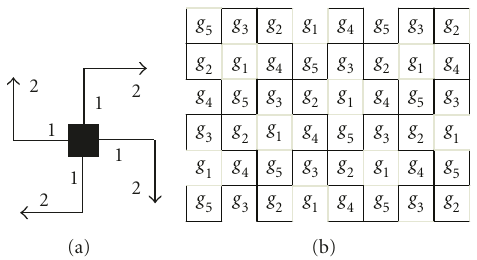
Figure 4: (a) Communication scheme and (b) activation groups in